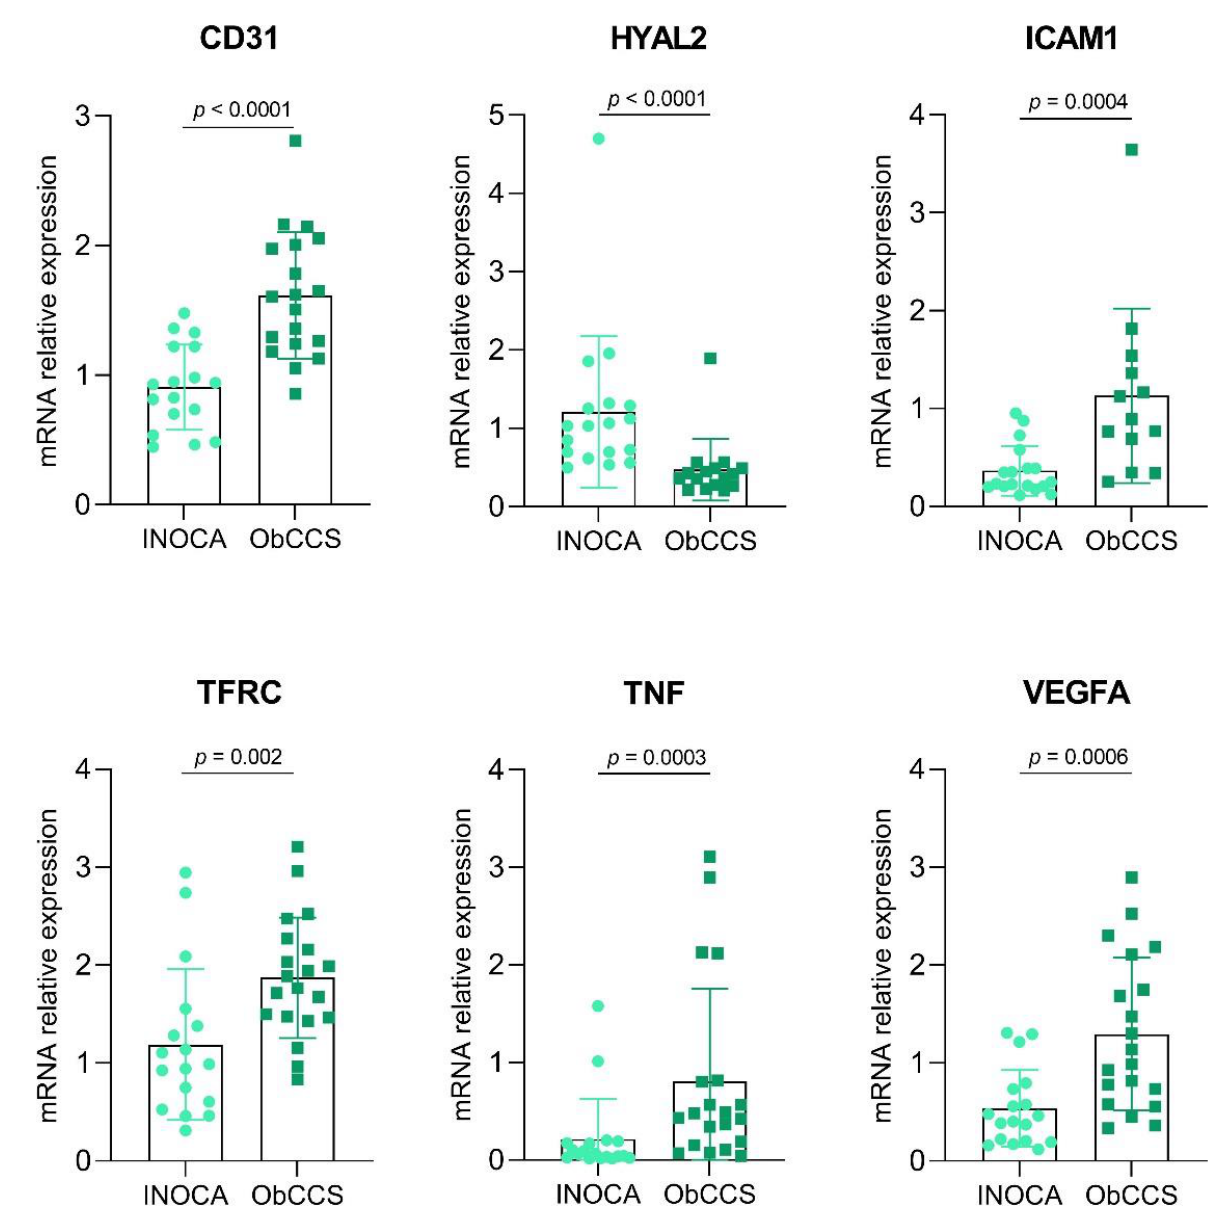
Figure 3. Histograms showing expression of PBMC-cDNAs of INOCA ( n = 18) and ObCCS ( n = 20) patients. INOCA = ischemia with non-obstructive coronary artery; ObCCS = obstructive chronic coronary syndrome; PBMC = peripheral blood mononuclear cell; CD31 = Platelet And Endothelial Cell Adhesion Molecule 1; HYAL2 = Hyaluronidase 2; ICAM1 = Intercellular Adhesion Molecule 1; TFRC = Transferrin Receptor; TNF = Tumor Necrosis Factor; VEGFA = Vascular endothelial growth factor A.